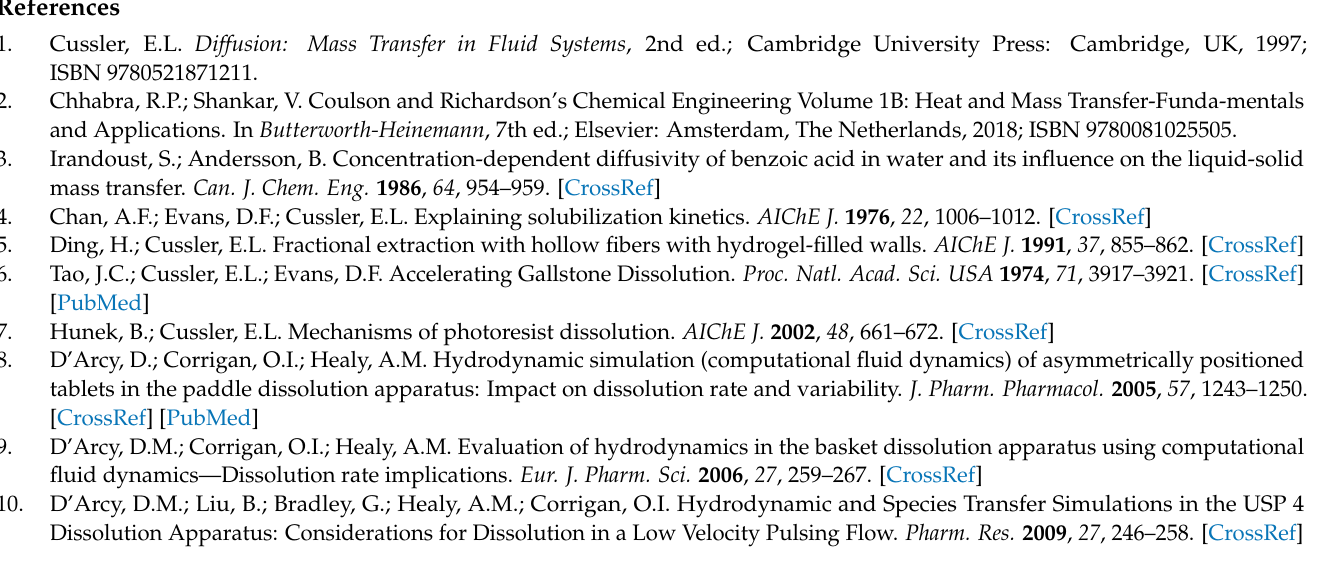
the mass-transfer coefficients in Table 1 (Beaker and stirrer system). Table S2: Corresponding temperatures for the experiments that measured the mass-transfer coefficients in Table 2 (USP dissolution apparatus 2). Reference [30] is cited in the supplementary